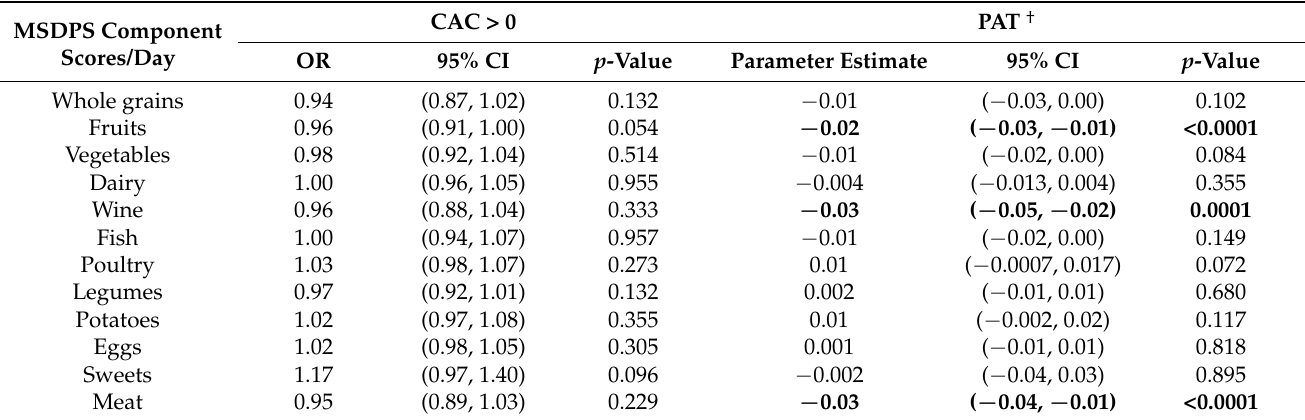
Table 4. Age, sex, diabetes status, HbA1c, and calories-adjusted analyses of the associations of Mediterranean-Style Dietary Pattern Score components with Coronary Artery Calcification presence and Pericardial Adiposity